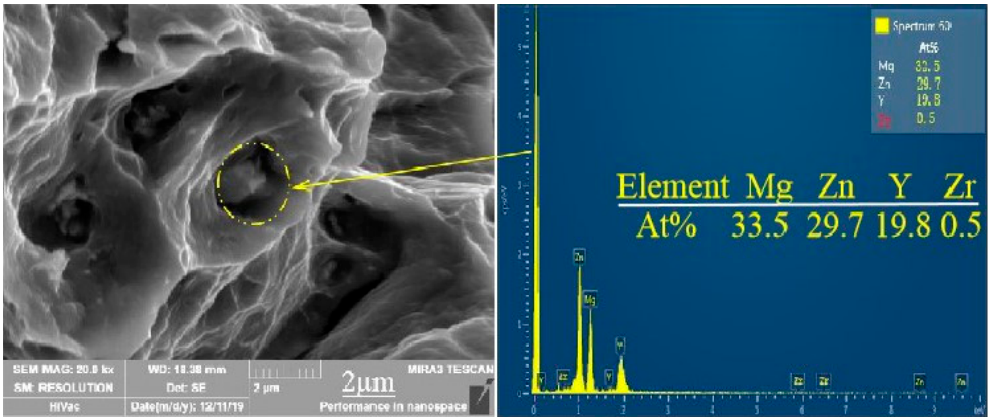
Figure 9. Microcosmic fracture morphology of extruded alloy at 300 ◦ C and corresponding EDS results.